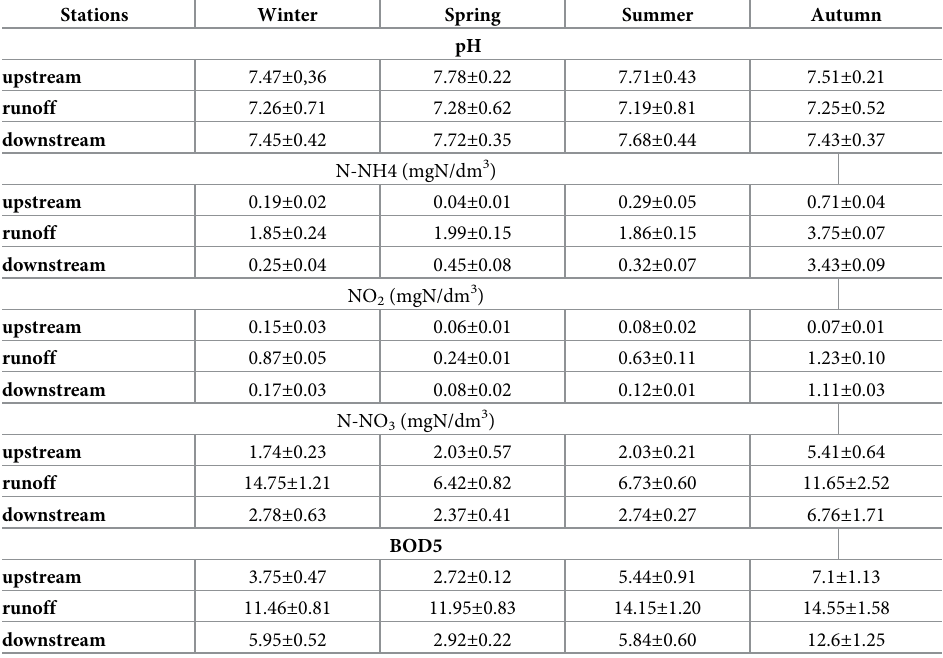
Table 2. Physical and chemical characteristics of investigated sections of river Uzh (average values period 2017–